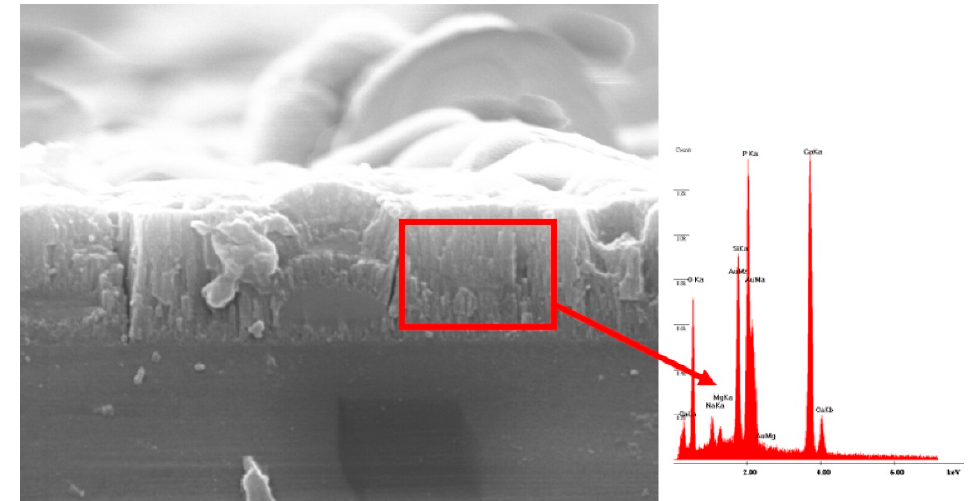
Figure 4. Cross-sectional SEM image and the corresponding EDS spectrum of a bovine hydroxyapatite doped with commercial inert glass coating synthesized by PLD.